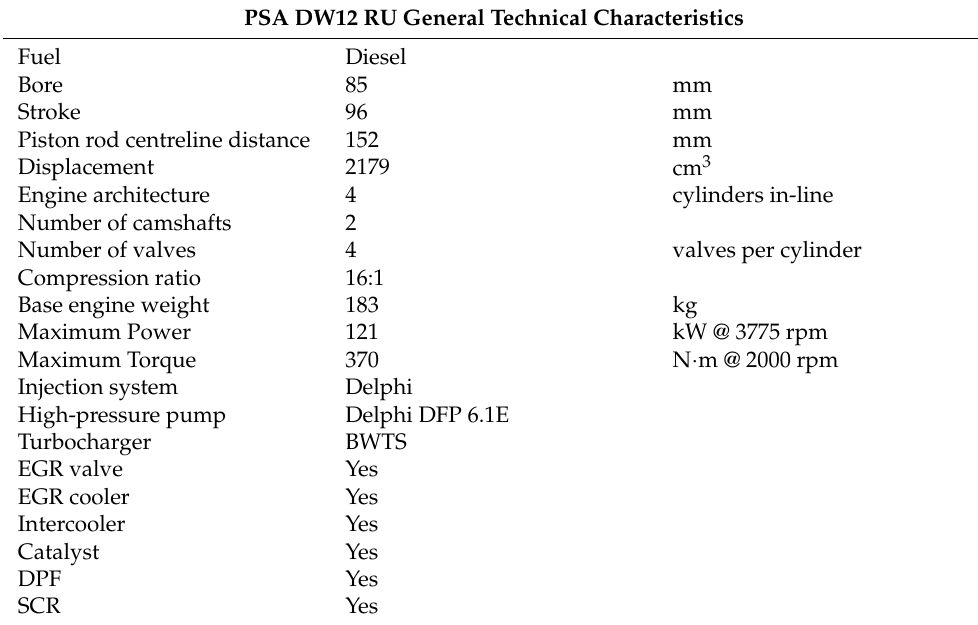
Figure A1. The performance curves of the PSA DW12 RU engines (Source: PSA). Figure A1 . The performance curves of the PSA DW12 RU engines (Source: PSA). Table A1. General Technical Characteristics of the tested engine (Source: Table A1. General Technical Characteristics of the tested engine (Source: PSA).